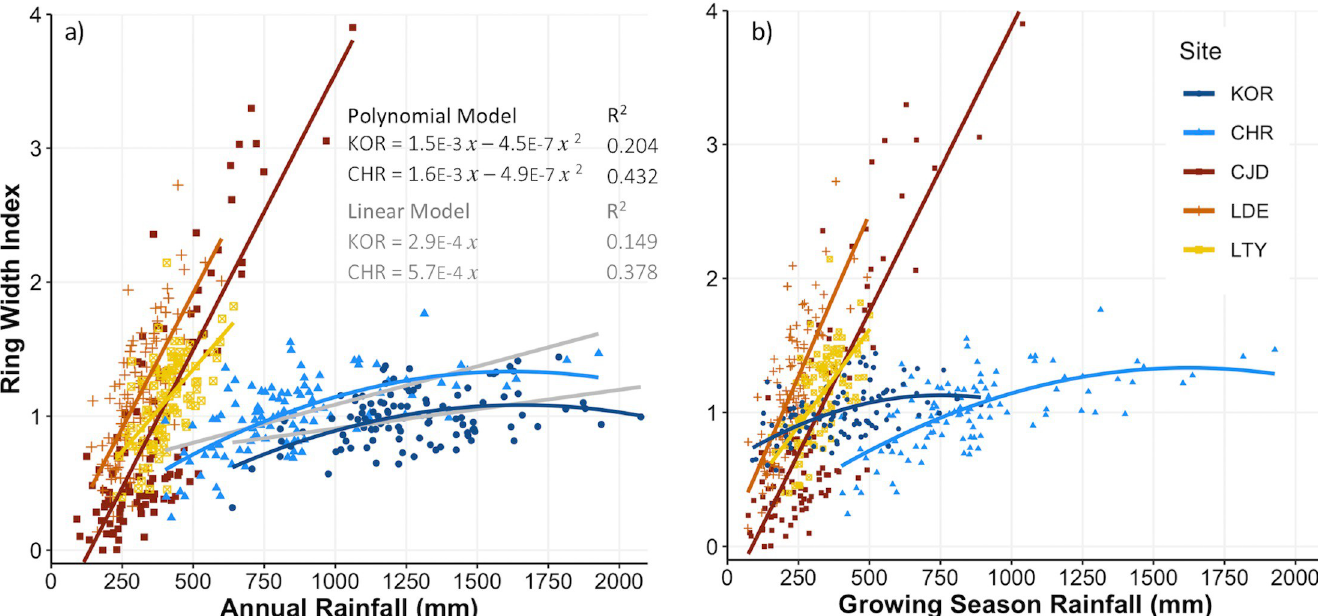
Fig 3. Relationship between ring-width index (RWI) and (a) annual or (b) growing season rainfall amount at the five Callitris columellaris sites. Each point represents data for one year. Lines represent fitted models; simple linear models for CJD, LDE and LTY and quadratic polynomial models for KOR and CHR. The fit of simple linear models for KOR and CHR are also shown in grey in (a).